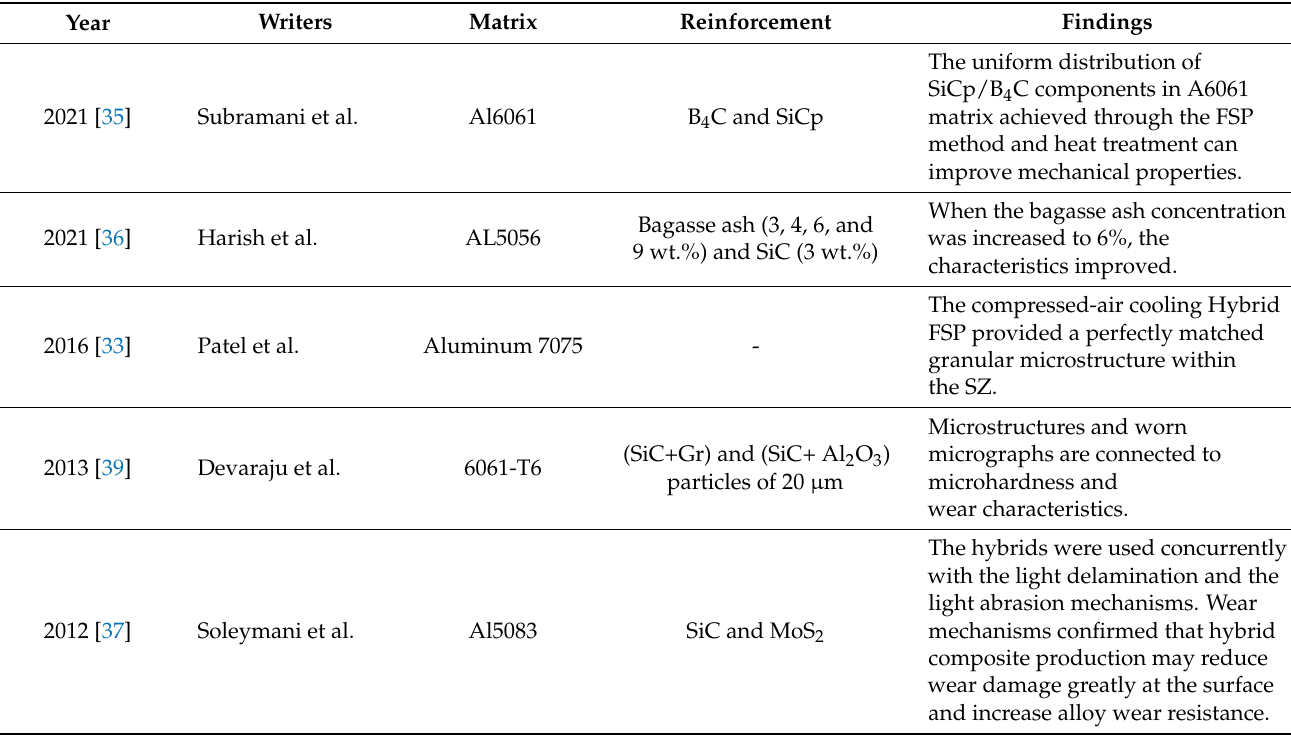
Table 2. Research article about friction stir